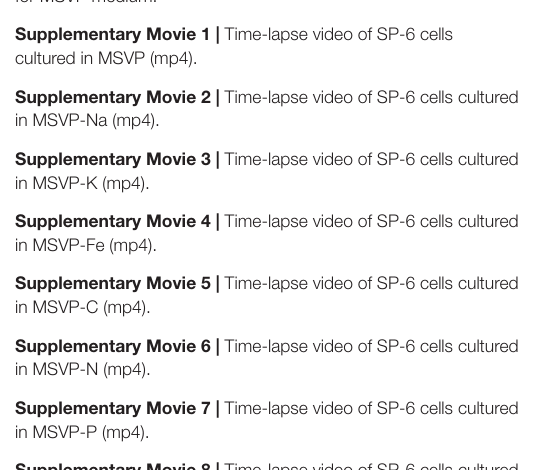
Supplementary Figure 1 | Typical cell filament elongation in MSVP. Supplementary Figure 2 | Cell filament elongation in MSVP-K. Supplementary Figure 3 | Cell filament elongation in MSVP-Fe. Supplementary Figure 4 | Time-lapse image sequence showing filamentous growth in MSVP-N, MSVP-P, and MSVP-V within the 2D chamber. Supplementary Figure 5 | The percentage of the filament filled with cells in MSVP-C, MSVP-N, MSVP-P, and MSVP-V. Supplementary Figure 6 | Fluorescent labeling of the sheath n MSVP-N, MSVP-P, and MSVP-V. Supplementary Figure 7 | ASEM snapshots of SP-6 cell filaments cultured in MSVP and MSVP-lowC. Supplementary Figure 8 | Autolytic cell death in MSVP-Mg. Supplementary Figure 9 | Characteristic elongation of cell filaments in MSVP-Ca. Supplementary Figure 10 | Cell filament breakage in MSVP-Ca(NH 4 Cl) medium. Supplementary Figure 11 | Cell filament elongation before and after EGTA treatment. Supplementary Figure 12 | Cell filament breakage caused by the EGTA treatment in 2xPYG medium. Supplementary Figure 13 | Combinatory limitations of a carbon source and Ca 2 + stimulate planktonic cell generation. Supplementary Table 1 | Composition of MSVP medium. Supplementary Table 2 | Composition of vitamin stock solution for MSVP